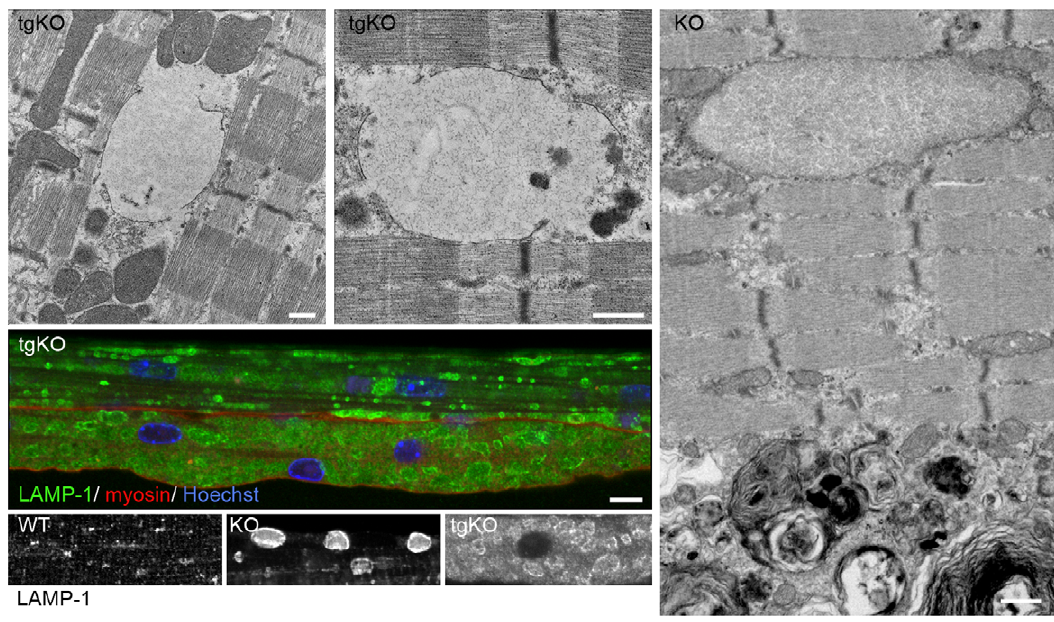
Figure 8. Lysosomal rupture in the converted fibers of tgKO. Electron microscopy of gastrocnemius fast muscles of 5 month-old tgKO (two top panels) and KO (right panel) mice. Several break points of the lysosomal membrane can be seen in the tgKO. Lysosomal membrane is preserved in the KO; autophagic buildup can be clearly seen. Bar: 500 nm. Middle panel: Single fibers (psoas muscle) from tgKO stained with LAMP-1 (green) and myosin-slow (red) showing multiple lysosomes with an irregular shape and broken borders in the lower fiber. Nuclei are stained with DAPI. Bar: 20 m m. Bottom panels: Single fibers (psoas muscle) from WT, KO, and tgKO stained with LAMP-1 (shown in white). Lysosomes appear as dot-like structures in the WT and as well-defined vesicles in the KO; only remnants of lysosomal membranes are detected in the tgKO.